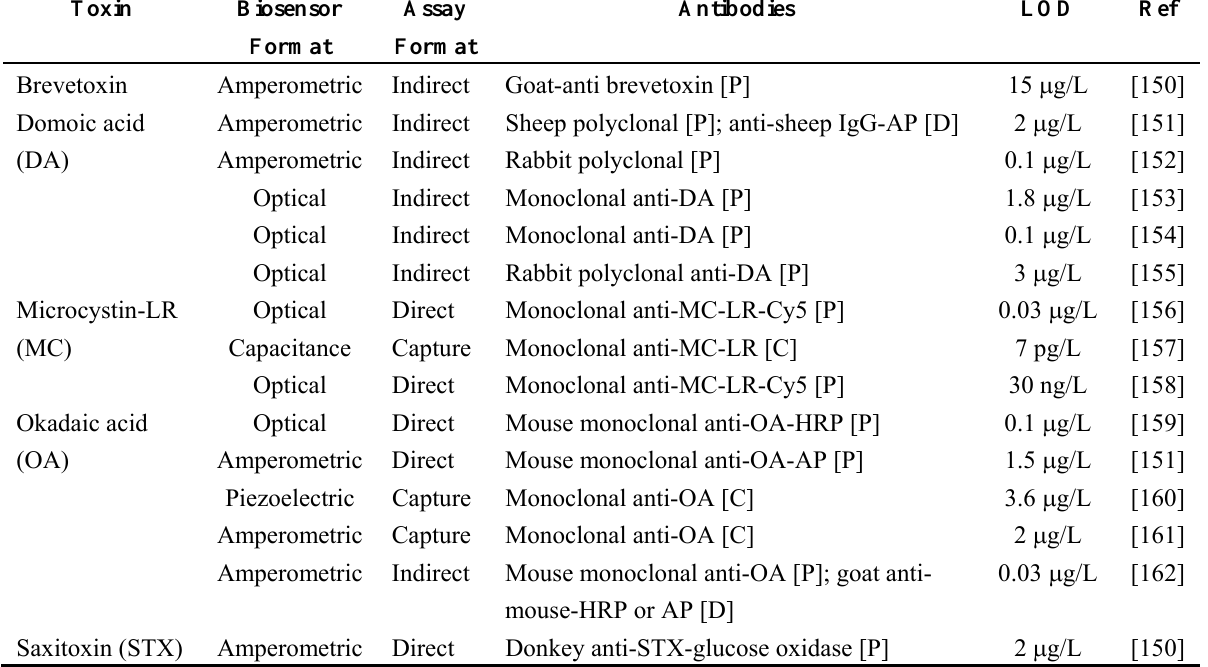
Table 6. A selection of immunosensor-based assays for marine algal toxin detection. Key: [C] - capture antibody; [P] - primary antibody; [D] - detection antibody; LOD - limit of